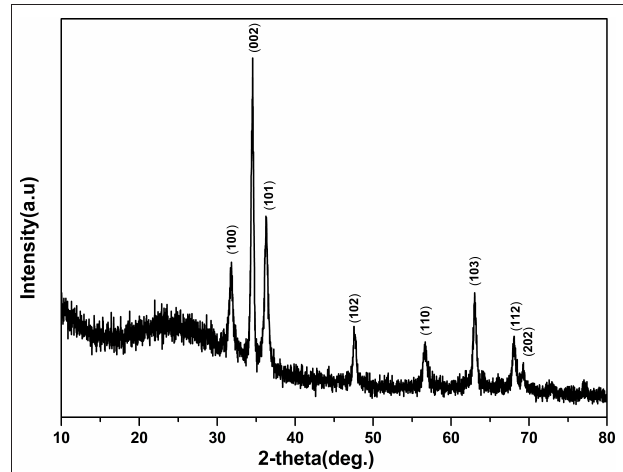
FIGURE 2 | X-ray diffraction patterns of the ZnO nanorod arrays coated on glass substrate with reaction times 4h.